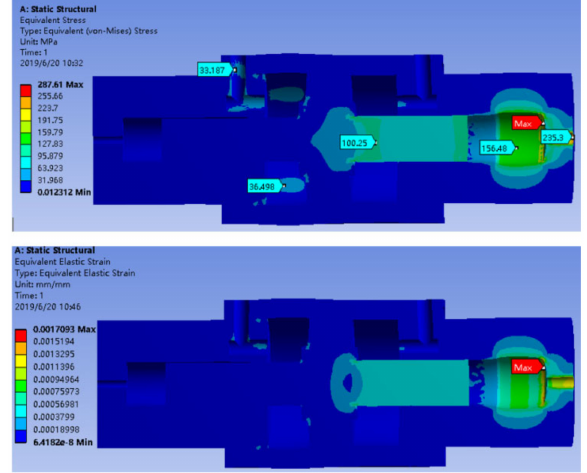
Figure 12. Stress analysis cloud and strain analysis cloud diagram when the piston is at the middle end.